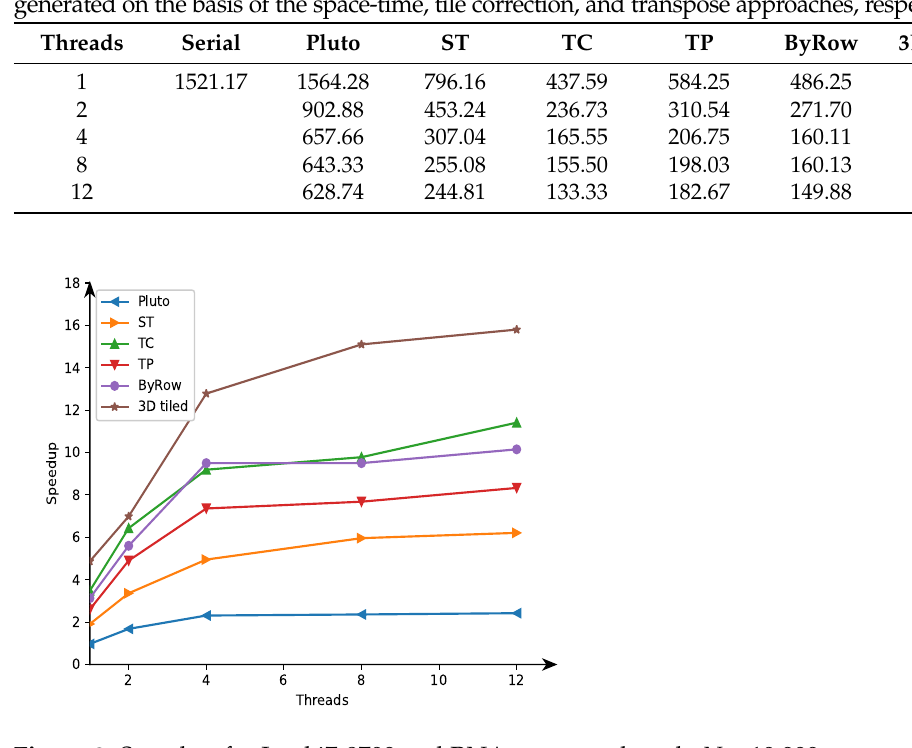
Figure 3. Speedup for Intel i7-8700 and RNA sequence length, N = 10,000. Table 5 presets execution times in seconds on Intel Xeon E5-2699 v3 and 36 threads used for code execution. The code generated with the approach presented in this